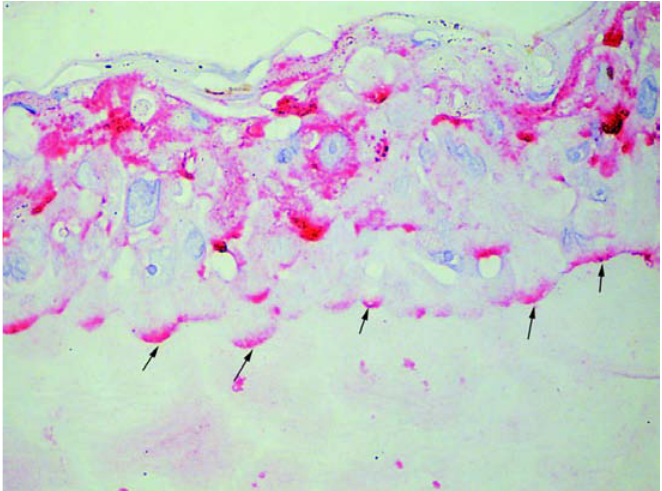
FIGURE 7 - Integrin beta-4 expression ( stained in pink ) in the various layers of keratinocytes, with a polarized pattern of expression at dermoepidermal junction ( arrows ), and almost absent at the level of the basal cells. (Light microscopy, x